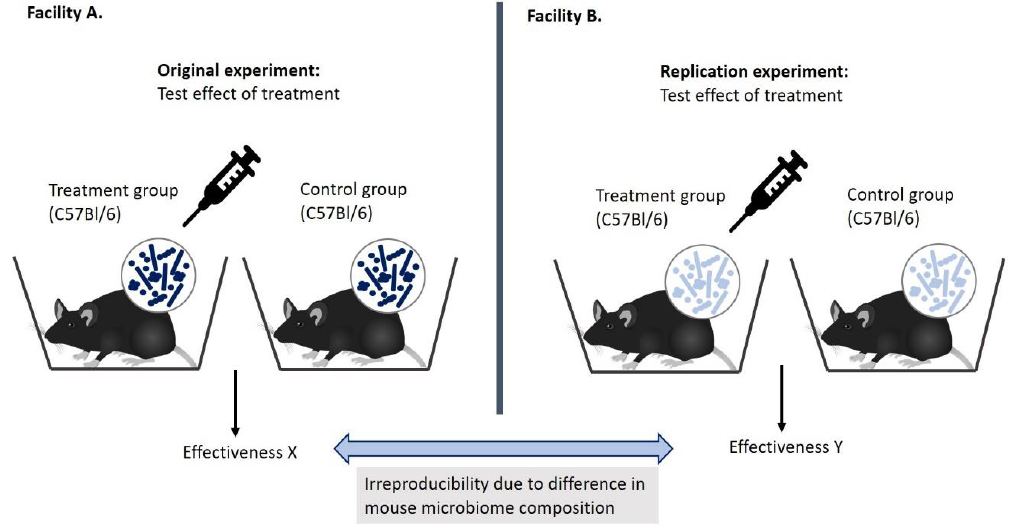
Figure 3. Variation in mouse microbiome composition can explain irreproducibility between (and also within) facilities as the effectiveness of a treatment might be specific to a certain microbiome within) facilities as the e ff ectiveness of a treatment might be specific to a certain microbiome composition composition and not generalizable to mice harboring different microbes. and not generalizable to mice harboring di ff erent